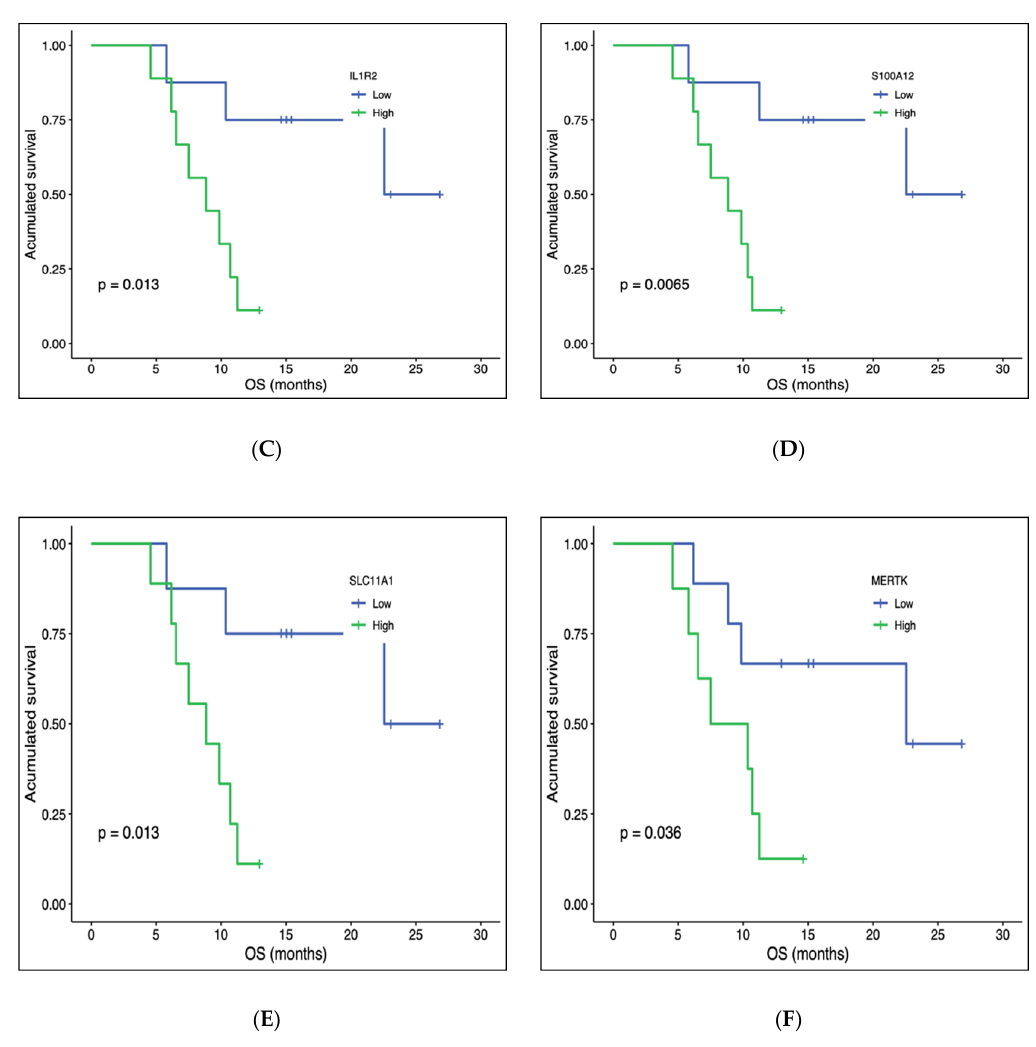
Figure 3. Kaplan–Meier overall survival analysis by baseline gene expression (only statistically significant genes are represented). ( A ) ARG1. ( B ) CD163. ( C ) IL1R2. ( D ) S100A12. ( E ) SLC11A1. ( F ) MERTK.